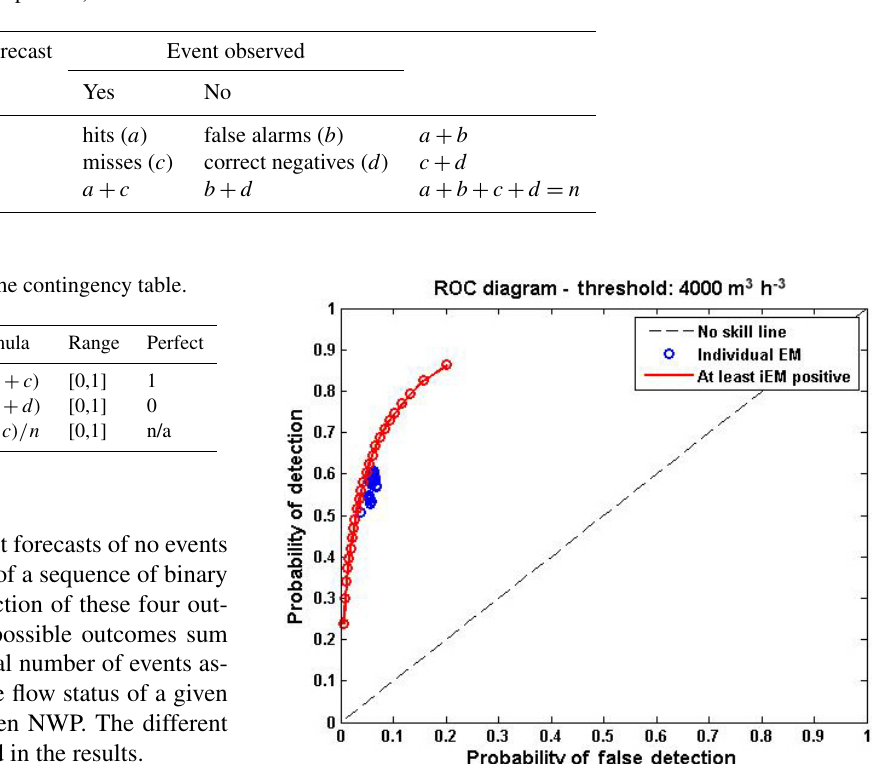
Table 1. Contingency table (with n the sample size).